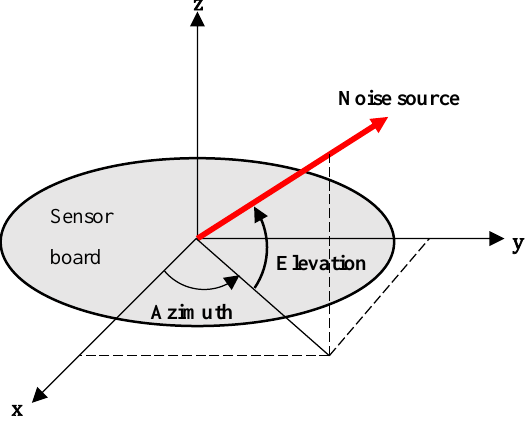
Figure 6. Two output angles of the localization system: Azimuth and elevation.